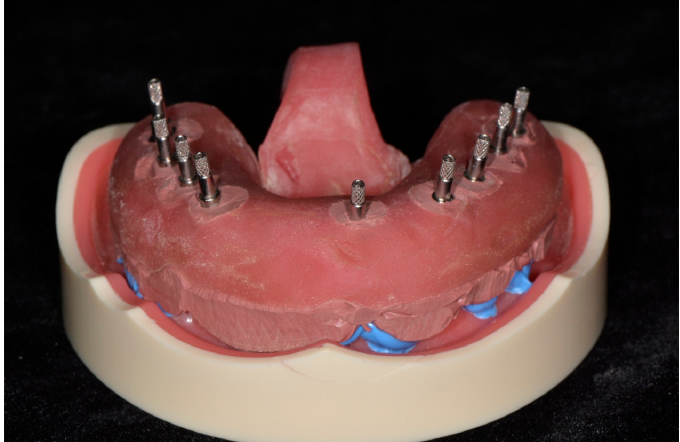
Figure 3. Obtaining the pick-up impression.